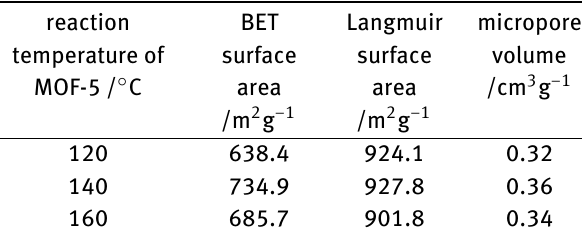
BET Langmuir micropore surface surface volume area area /cm 3 g −1 /m 2 g −1 /m 2 g −1